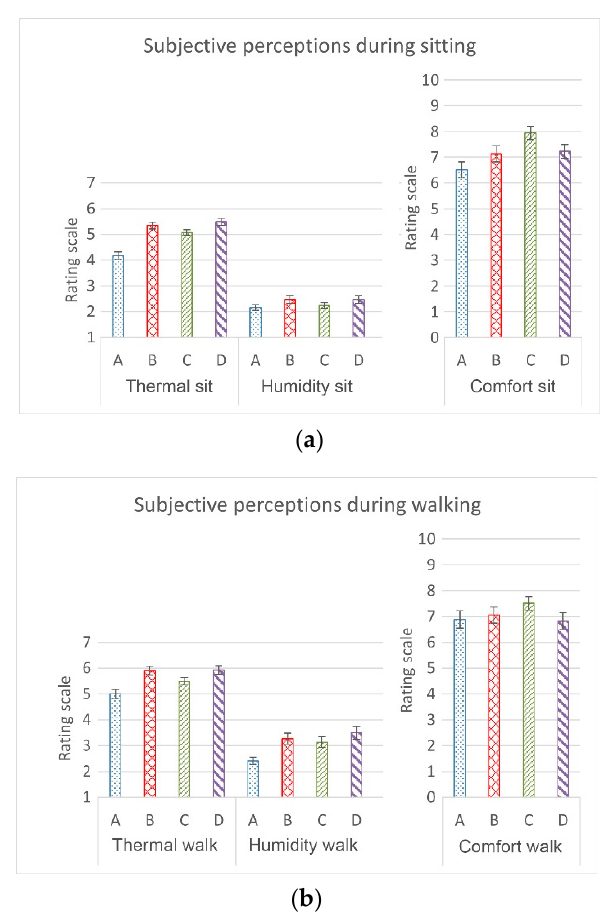
Figure 9. Subjective sensations with different footwear conditions during ( a ) sitting and ( b ) walking, where A: barefoot, B: leather sports shoes, C: mesh sports shoes, and D: closed-toe